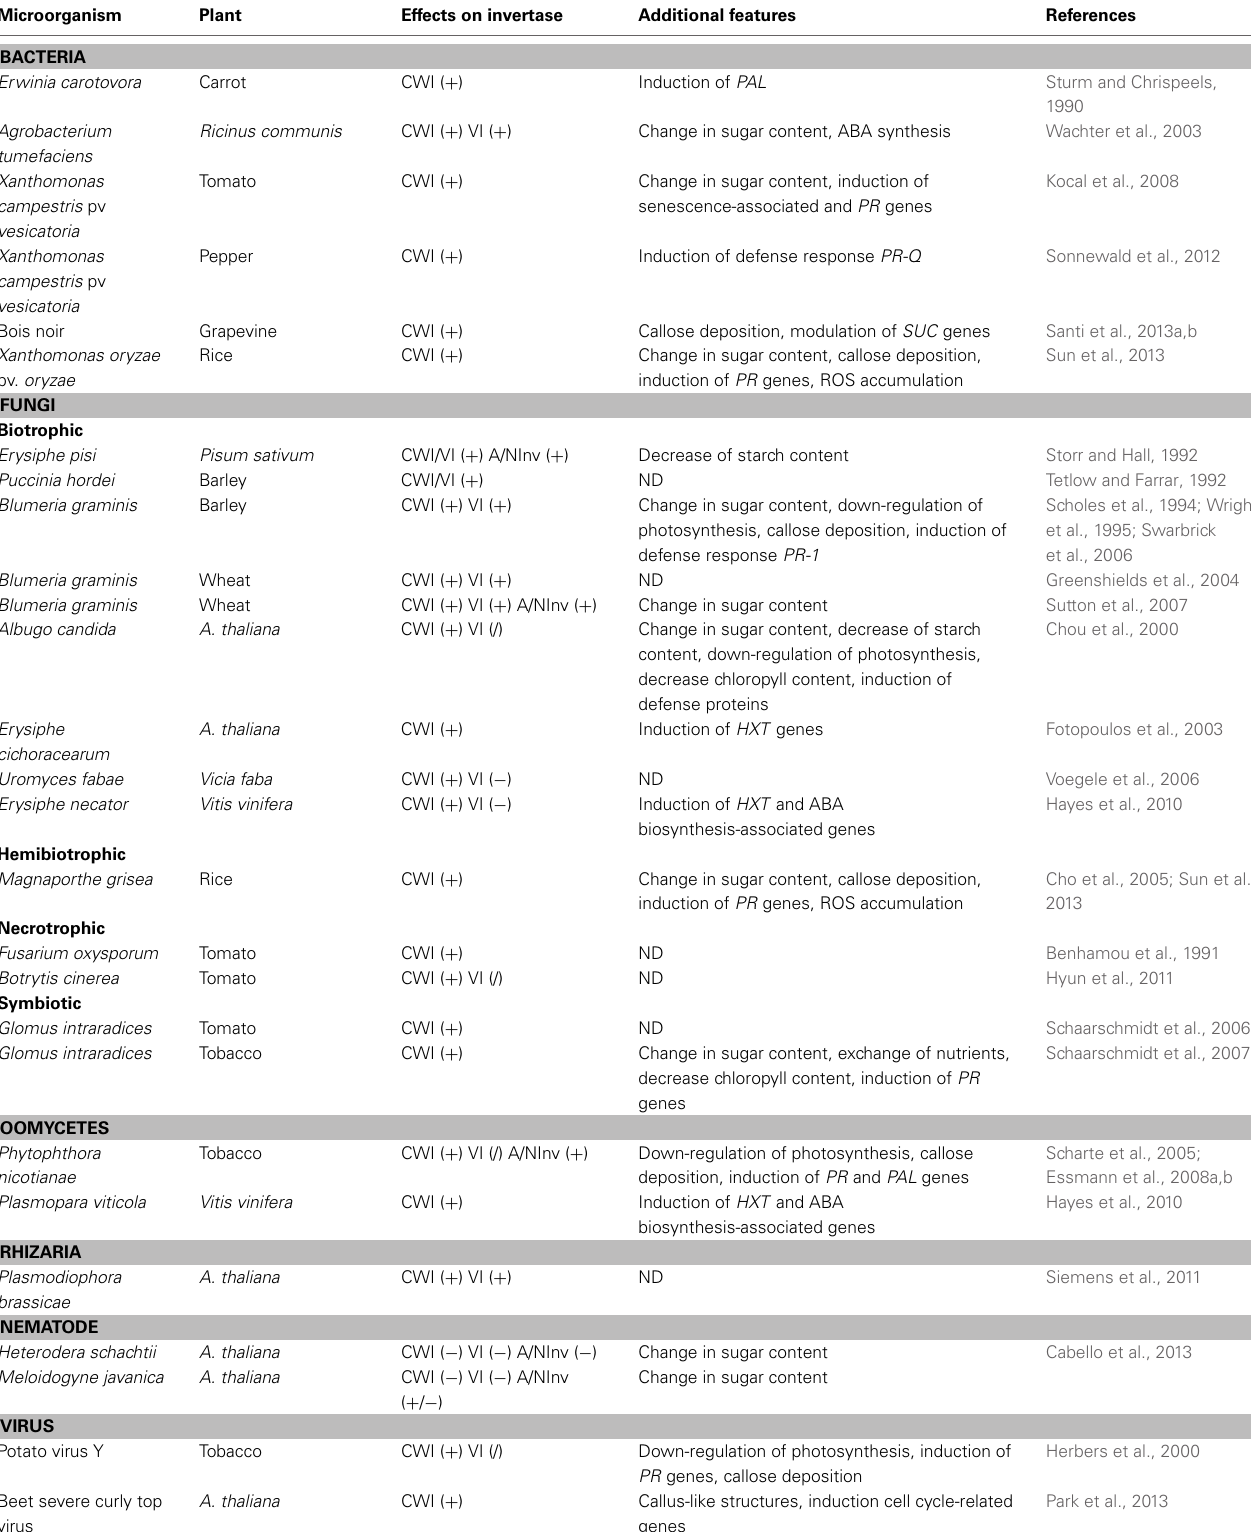
Table 1 | Summary of plant pathogen interaction studies referring to invertase modulations.